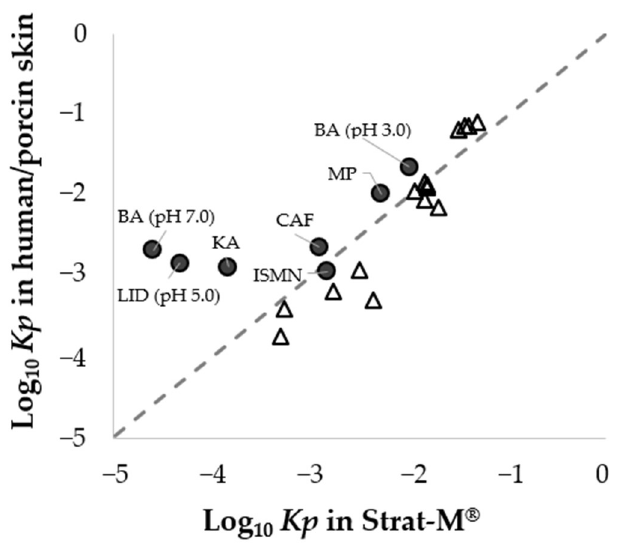
Figure 7. Comparison of Kp values between our research (porcine skin) and the published research (human skin). Circles ( ● ) represent our dataset (−2.3 ≤ Log K ow ≤ 2.0), while unfilled triangles (Δ) represent the published dataset (−0.9 ≤ Log K ow ≤ 3.5, Uchida et al., 2015), and the dashed line corresponds to factor 1. Each point represents the mean ( n = 3−4).